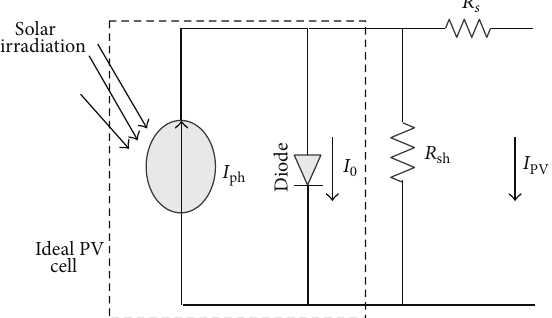
Figure 2: Circuit diagram of single diode PV